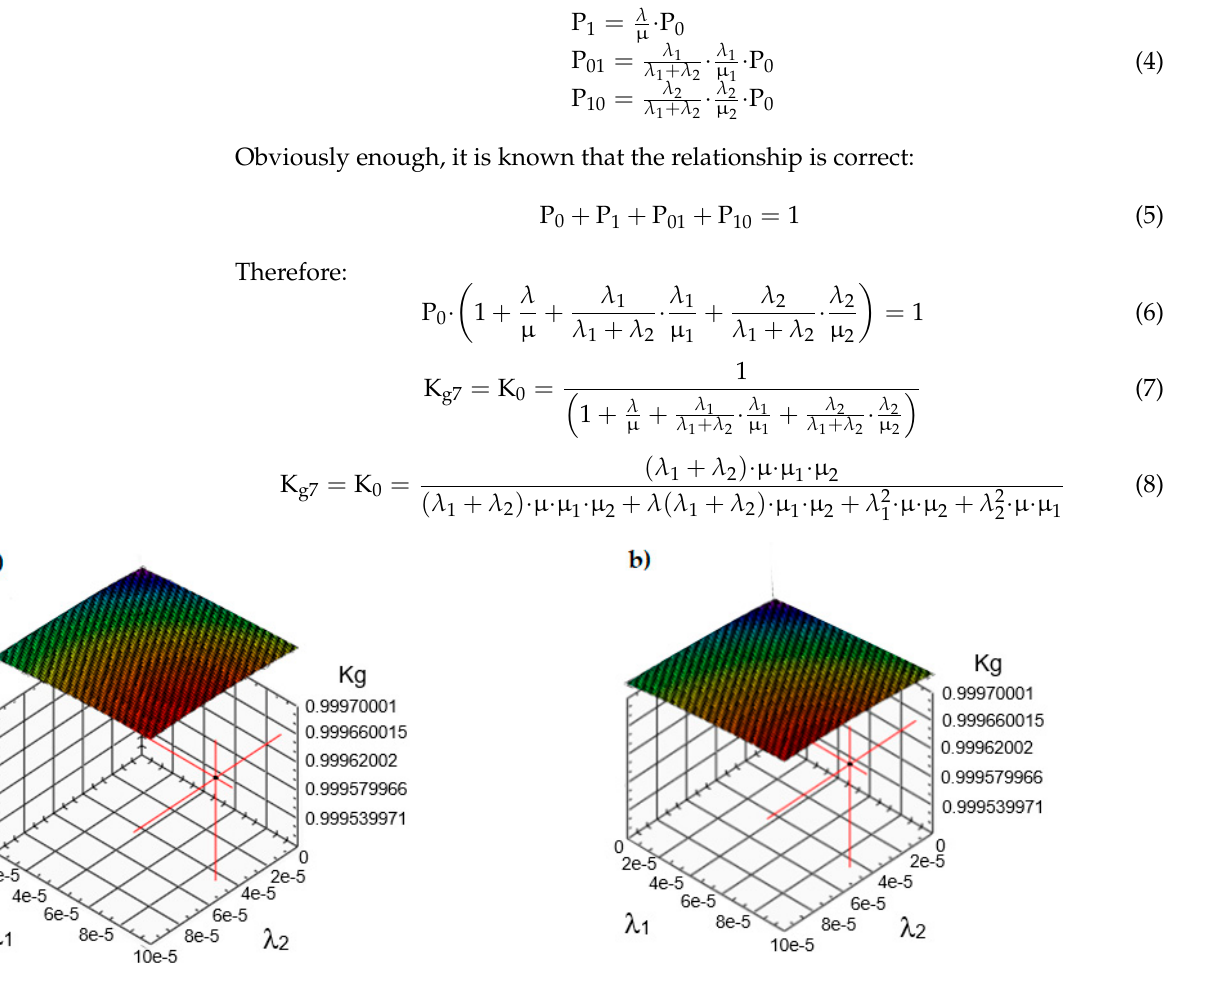
Figure 5. Graphs of the K g availability coefficient in the process of testing the reliability of wind farm devices by changing the value of the average repair time for constant parameters, including: type I mean service time = 0.8 [h]; type II mean operating time = 1.3 [h]; mean time between successive failures = 1200 [h]. where: ( a ) average repair time 0.5 [h]; ( b ) average repair time 0.6 [h].